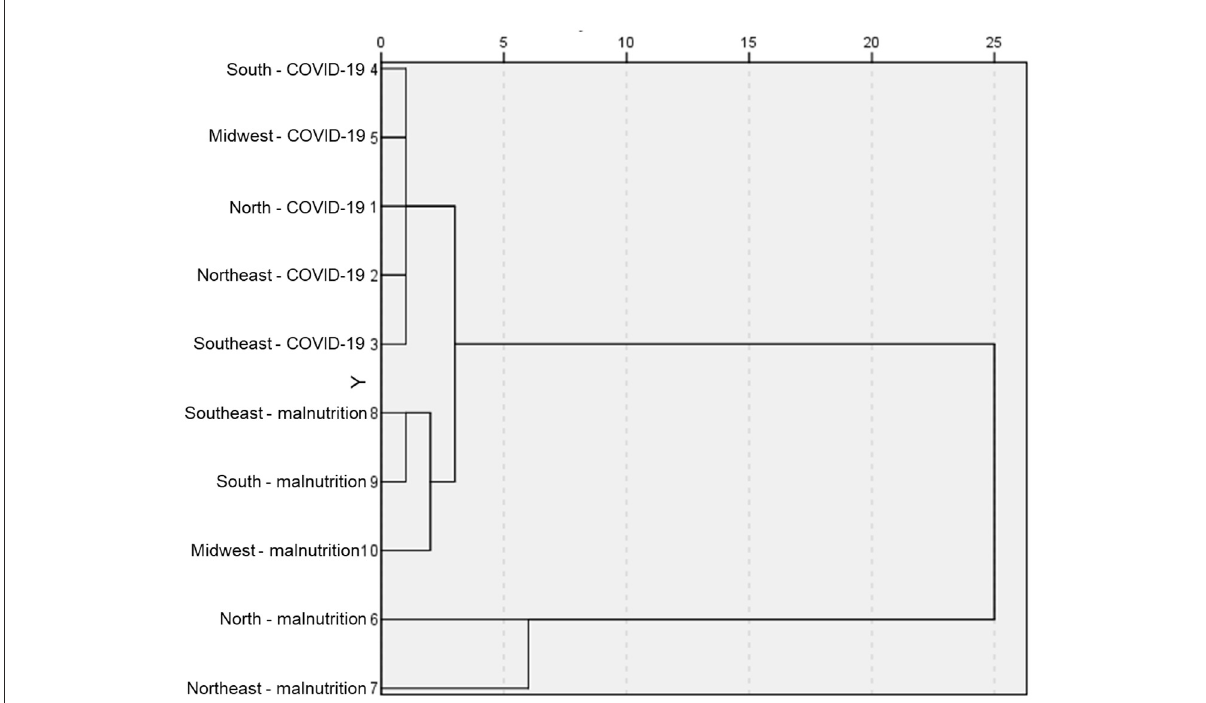
FIGURE5 Analysis of (dis) similarity between the prevalence of mortality from malnutrition and COVID-19, in the different macro-regions of Brazil. Data were previously collecte’d from a digital collection and made available by the Ministry of Health. The (dis)similarity matrix was determined after evaluating the Euclidean distance. The dendrogram was used to assess the